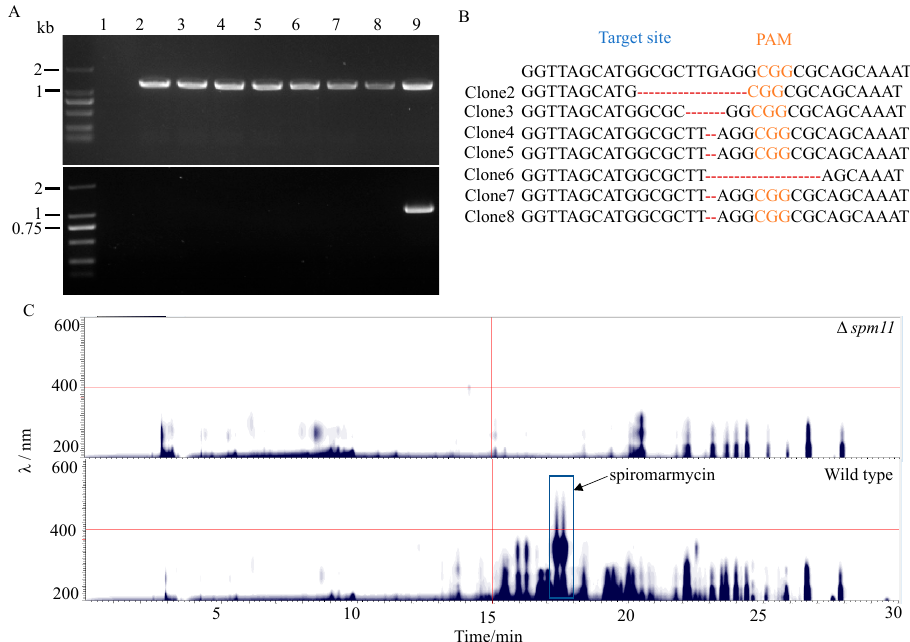
Figure 6. Inactivation of spm11 in Spiromastix sp. SCSIO F190 using the amdS -based CRISPR-Cas9 system. ( A ) DNA amplification of the DNA region surrounding the sgRNA binding site of the eight clones with different phenotypes from wild type plate using primers flanking the PAM site in the spm11 gene (Upper panel) and primers with one forward primer targeted the sgRNA binding site (Lower panel). PCR amplification with the same primers of DNA from the wild type strain served as positive control. (Lane 1–8: tested transformants; lane 9: wild-type strain.) ( B ) Sequence analysis of PCR products of clones 2–8. ( C ) HPLC-DAD contour plot of extracts from the wild-type and ∆ spm11 mutation strains. The boxed region indicates